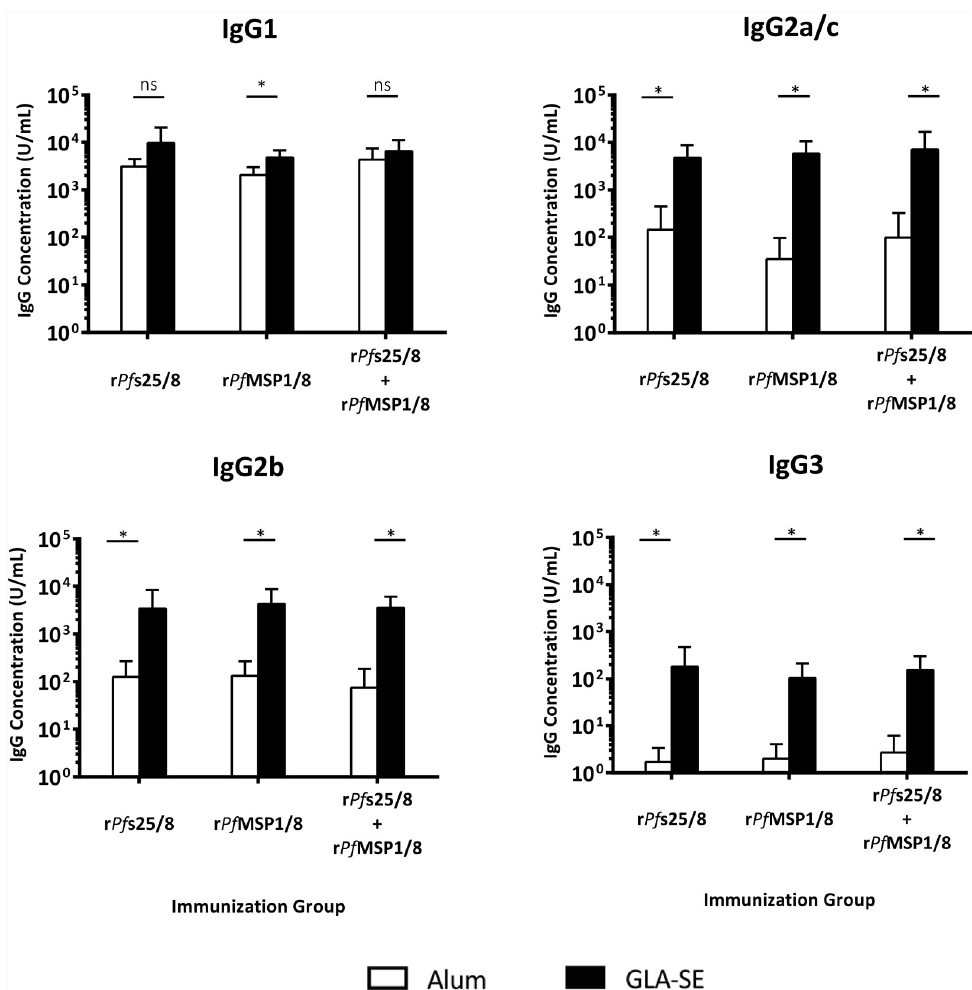
plates coated with r Pf MSP8 (0.25 μ g/well). Graphs depict mean IgG subclass concentration (U/ml) +/- standard deviation. Comparisons of two corresponding groups that differed by adjuvant only were conducted and asterisks over horizontal lines indicate significant differences between groups (Mann-Whitney U Test; P < 0.05 considered